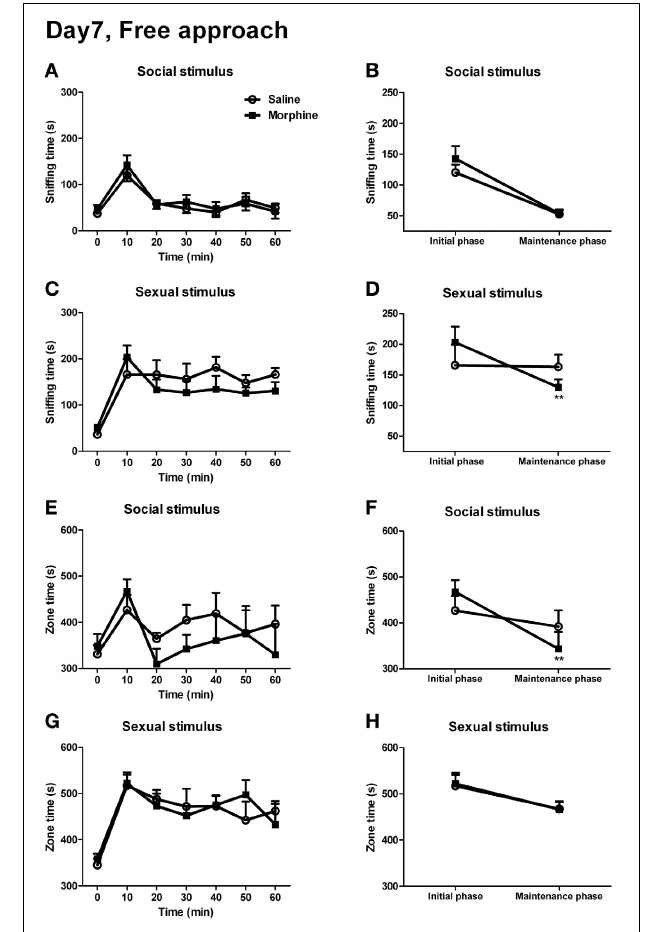
FIGURE 8 | The effects of morphine withdrawal on appetitive motivations for social or sexual reward in male rats under a free-approach condition (i.e., during the simple appetitive behavior testing). The 60-min testing (10min/block) was performed on day 7 of withdrawal. (A,C) The time spent on sniffing the stimulus-cage holding a male or an estrous female rat. (E,G) The time spent in the incentive zone adjoined to the stimulus-cage holding a male or estrous female rat. (B,D) The sniffing time during the first 10-min block of the testing (initial phase) and the mean value of sniffing time during the last five 10-min blocks of the testing (maintenance phase) spent on the stimulus-cage holding a male or an estrous female rat. (F,H) The zone time during the initial phase of the testing and the mean value of zone time during the maintenance phase of the testing when the stimulus-cage held a male or an estrous female rat. Stars indicate a significant difference between maintenance phase and initial phase, ∗∗ P < 0 . 01. Values are mean ±